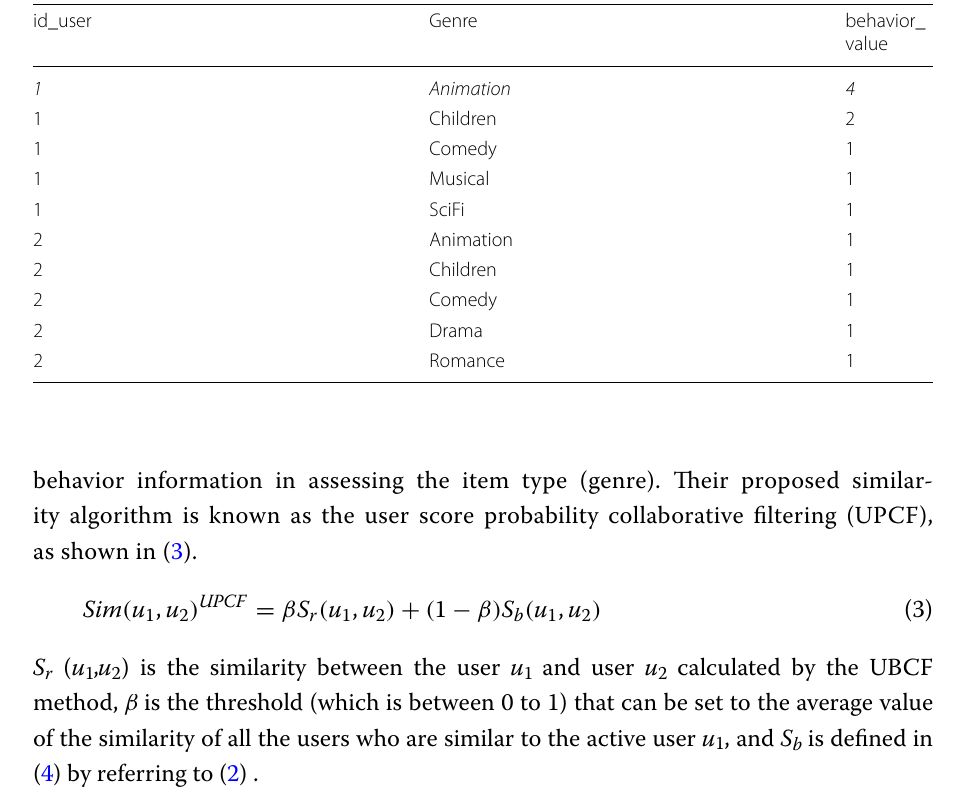
Table 4 User behavior